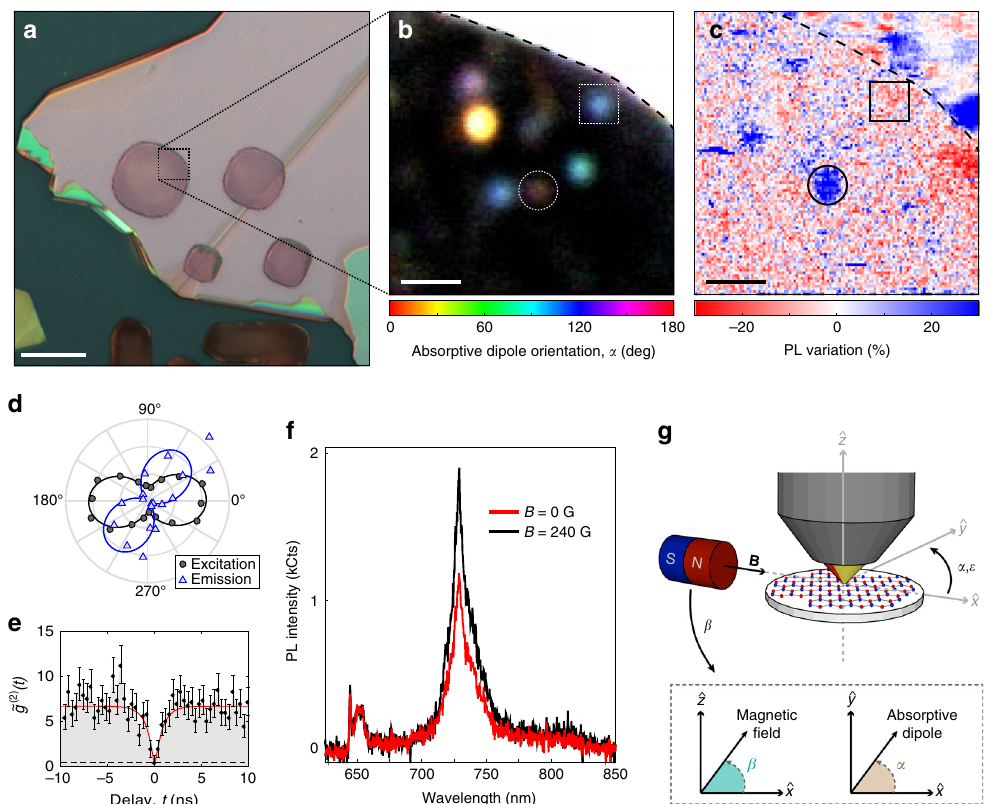
Fig. 1 Identi fi cation of fi eld-dependent quantum emitters. a Optical microscope image of an exfoliated h-BN fl ake on a patterned substrate. Scale bar denotes 10 μ m. b Polarization-resolved PL image of suspended h-BN [denoted by the dashed box in a ] at B = 0 G. The dashed curve indicates the edge of the suspended region. Color and brightness denote the absorptive dipole orientation and PL intensity, respectively 21 . Scale bar denotes 1 μ m. c Background- subtracted differential PL variation image from b identifying changes due to an in-plane magnetic fi eld ( B = 240 G). Blue (red) denotes increased (decreased) PL when B ≠ 0. Scale bar denotes 1 μ m. d – f correspond to the QE circled in b and c : d Background-subtracted PL excitation (circles) and emission (triangles) polarization dependences. Curves denote fi ts to the data. e Photon autocorrelation function (points) with a fi t to a three-level emission model (curve). Data are corrected for a Poissonian background, and error bars represent the Poissonian uncertainty based on photon counts in each bin. The dashed line shows the single-photon emission criterion. f PL spectra with and without an in-plane magnetic fi eld parallel to the QE ’ s absorptive dipole. g Illustration of the coordinate system for magnetic fi elds with respect to the microscope objective and sample. β , in the ^ x - ^ z plane, de fi nes the angle of the magnetic fi eld with respect to the sample plane and α ( ε ), in the ^ x - ^ y plane, denotes the absorptive (emissive) dipole